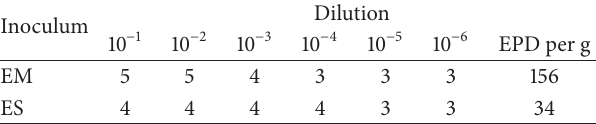
Figure 2: Plant height of P. patula seedlings as a function of EM and ES inoculation at each level of serial dilution. Table 1: Number of roots (of five) with presence of ectomycorrhizal features and estimated ectomycorrhizal propagule density (EPD) per gram of substrate.